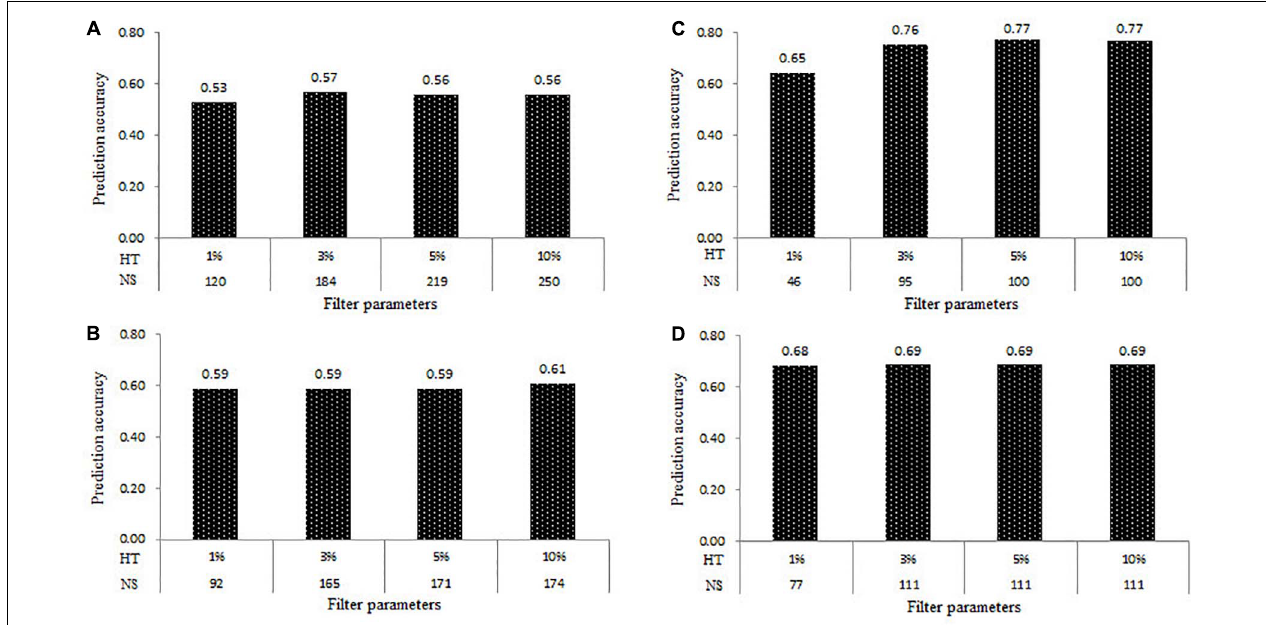
FIGURE 4 | Genomic prediction accuracies for TSC resistance obtained in the four populations of the (A) DTMA association mapping panel, (B) Pop1, (C) Pop2, and (D) Pop3, at the four levels of heterozygosity rate (HT) of samples of 1, 3, 5, and 10%, and the different number of samples (NS).